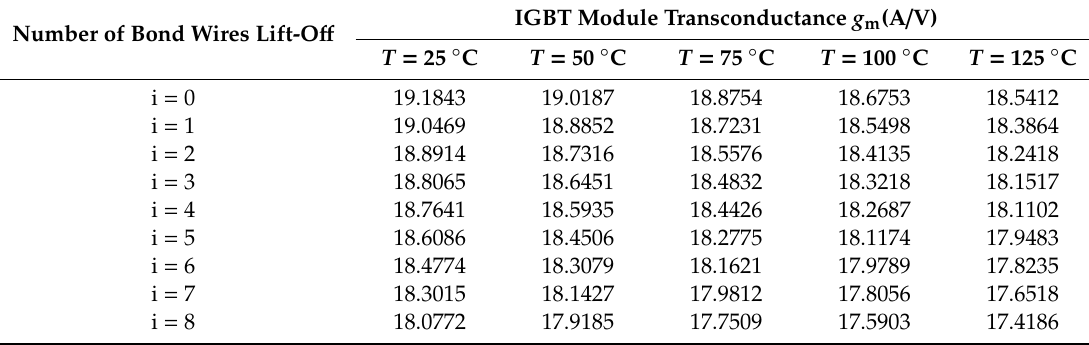
Table 6. Module transconductance of Chip 1 in bond wire fault states at di ff erent temperatures. Number of Bond Wires Lift-O